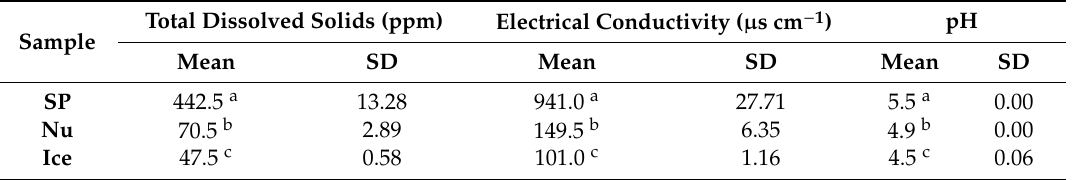
Table 3. Means and standard deviation (SD) of chemical data. Di ff erent letters denote significant di ff erences between samples assessed using the Fishers least significant di ff erence test with α = 0.05.